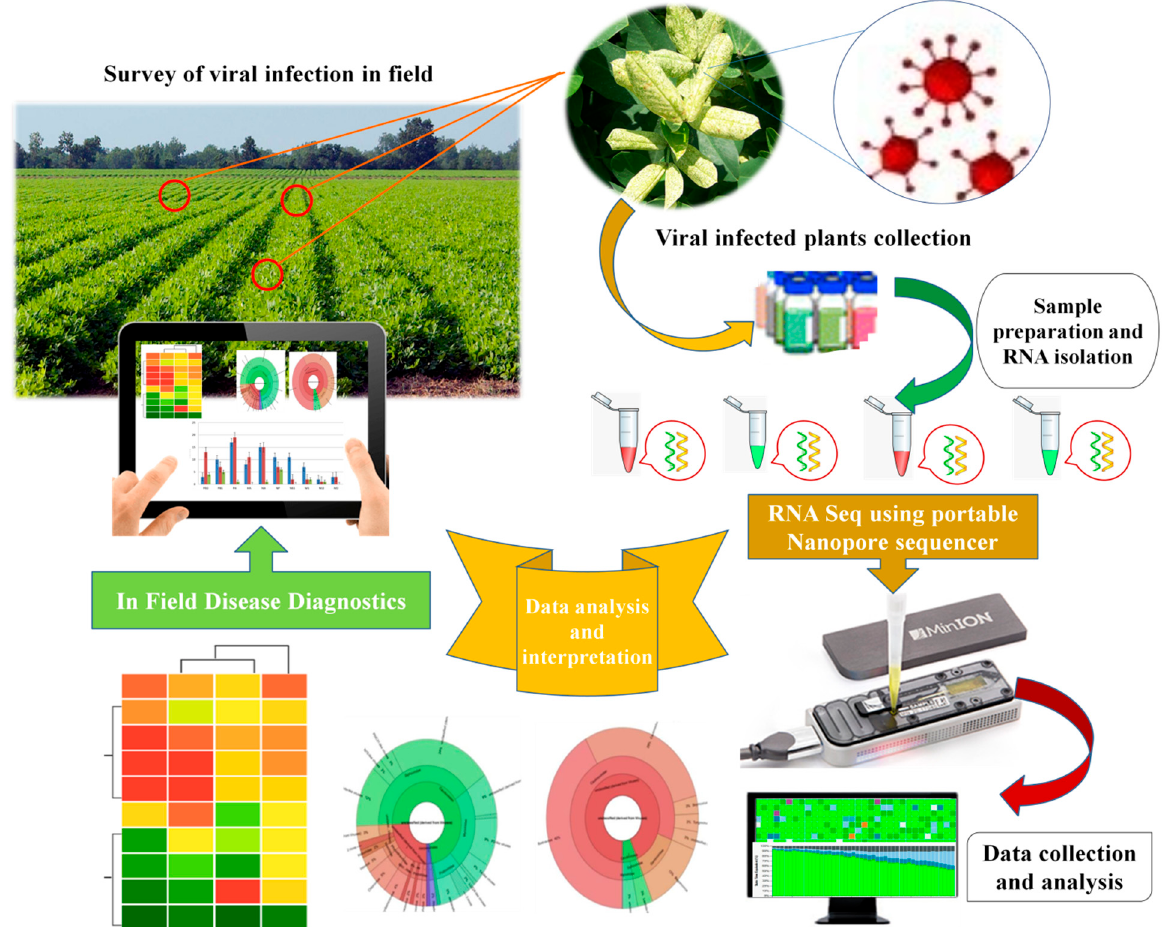
Figure 3. A putative workflow for rapid and on-site diagnosis of plant viral infections using portable sequencing device (MinION) developed by ONT, UK.